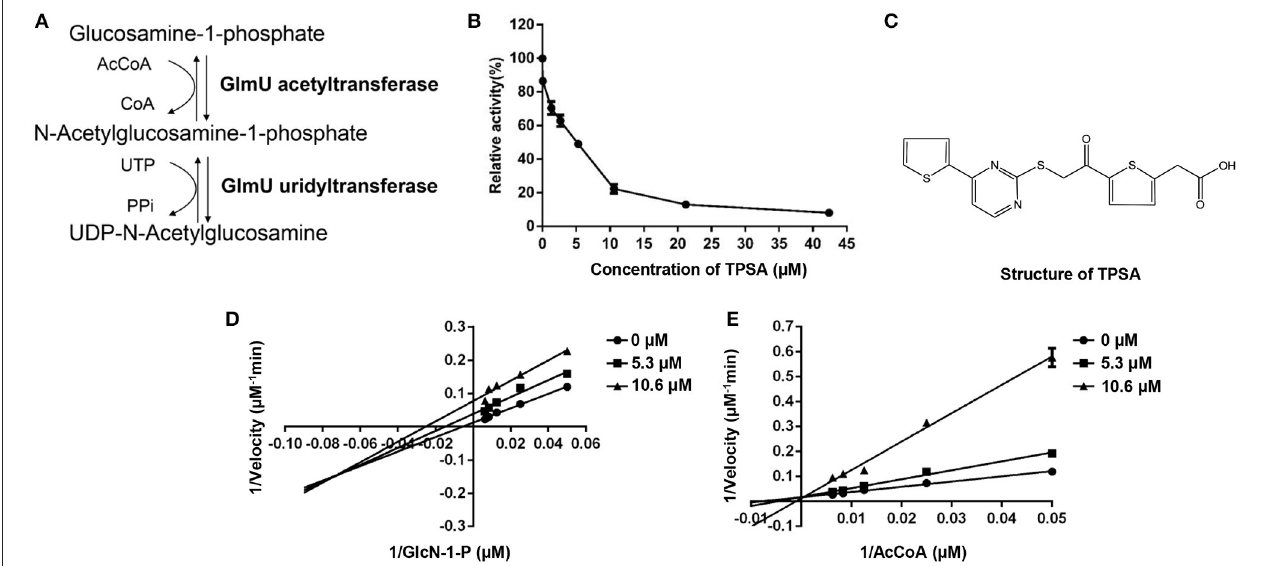
FIGURE 1 | The enzymatic reactions catalyzed by GlmU (A) and the inhibition effect of TPSA on GlmU acetyltransferase activity (B) , molecular structure of TPSA (C) , and the inhibition types of TPSA on GlmU acetyltransferase (D,E) . Double reciprocal plots showed 1/v vs. 1/s, where v was the initial velocity and s was the substrate concentration for GlcN-1-P and AcCoA. In (B,D,E) , the values plotted are the mean value and standard deviation from triplicate experiments.